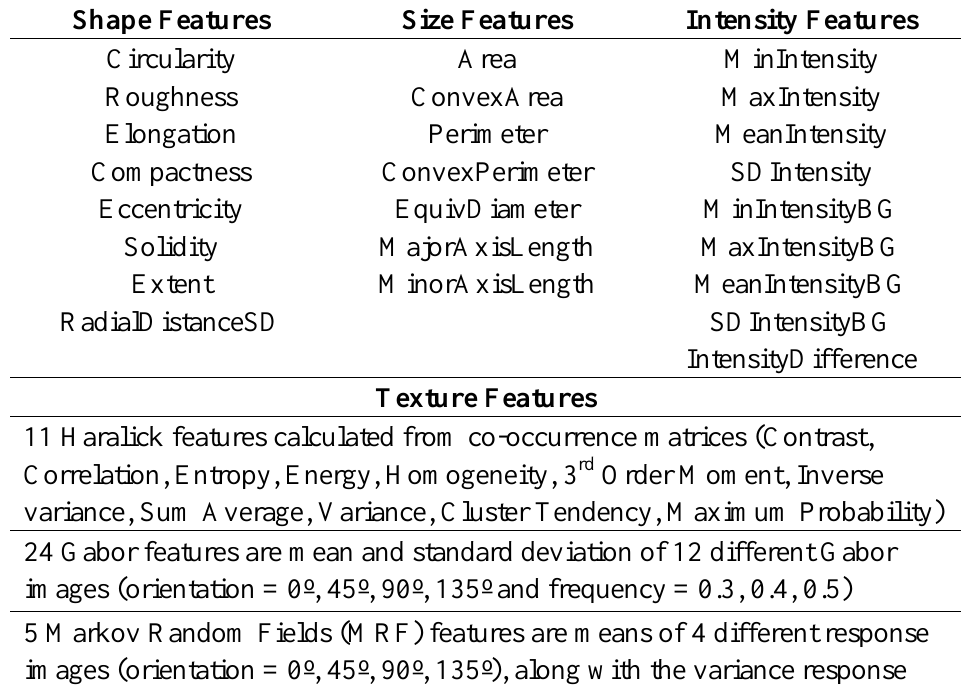
Table 3. Image features extracted from each lung nodule’s region of interest; SD stands for standard deviation and BG for